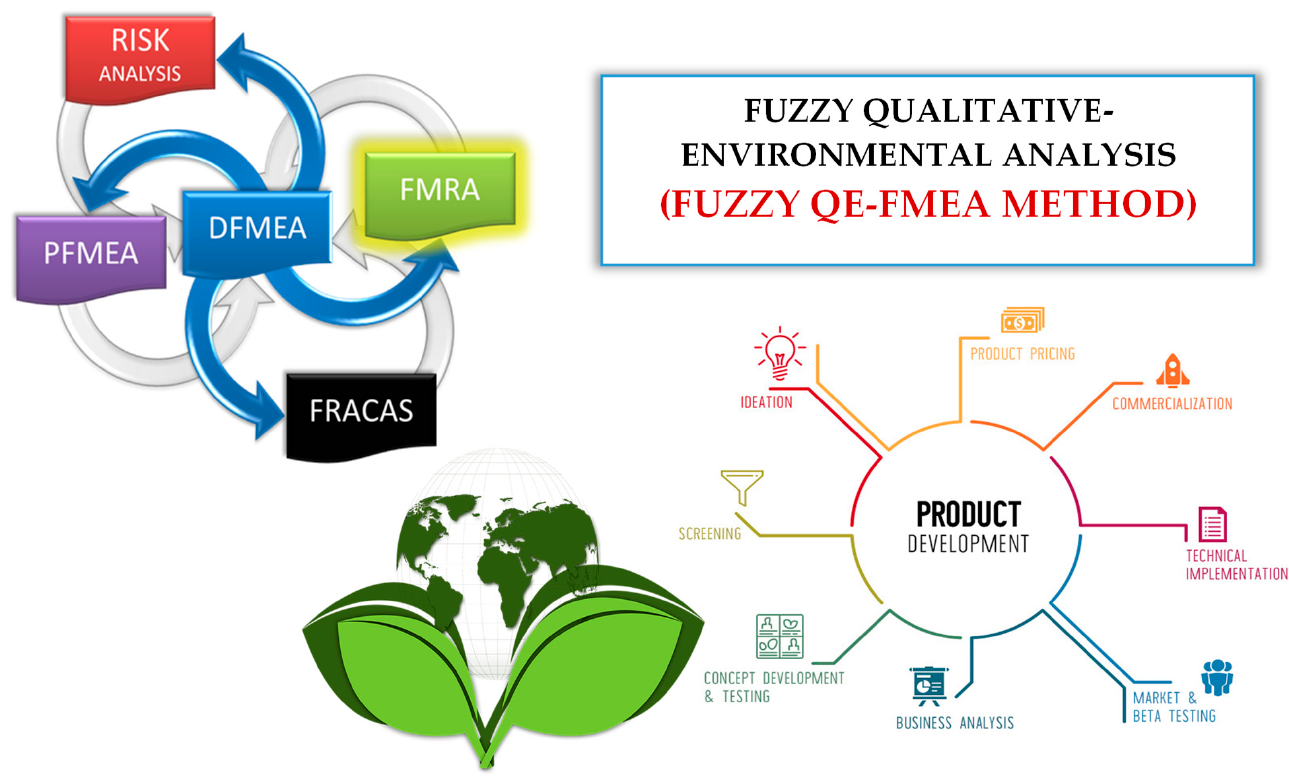
Figure 1. Workflow in the Fuzzy QE-FMEA method.